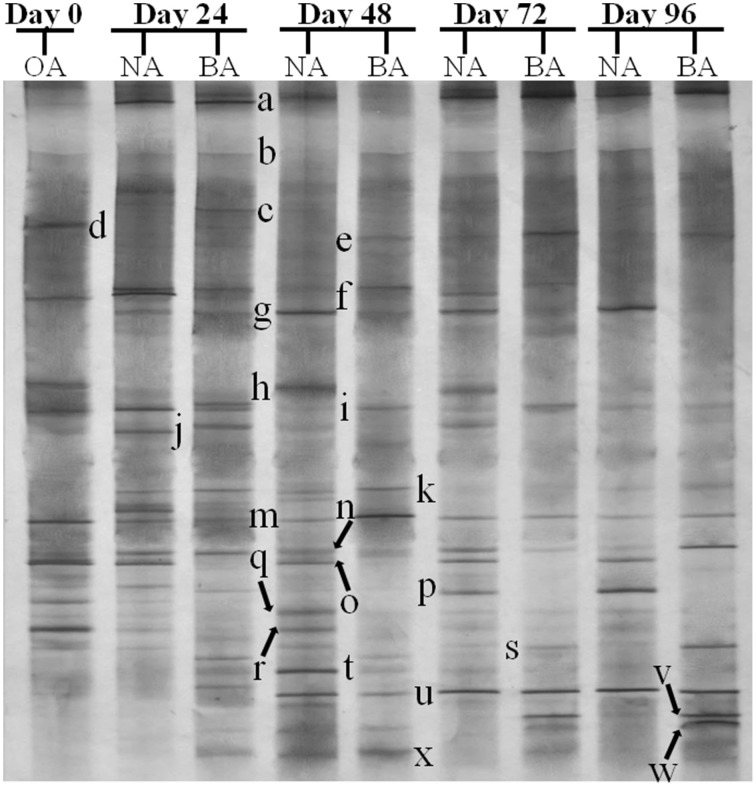
DGGE fingerprinting profiles of the CYP153 gene from the activated sludge samples at different periods during reactor operation, indicating the change in microbial diversity and community composition. OA, represents the original activated sludge; NA, represents the activated sludge from non-trehalose BA reactor; BA, represents the activated sludge from the trehalose BA reactor.